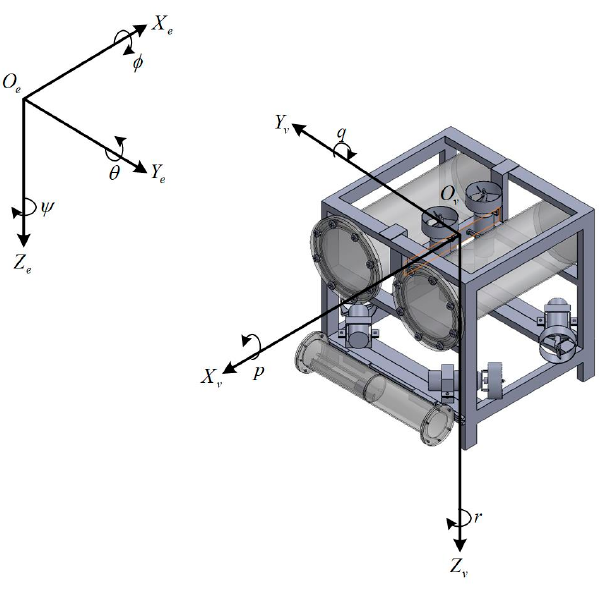
Figure 1. Description of ROV movement using the Earth and vehicle coordinate systems.